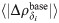
Phase-locking changes at WP1 are driven by local excitations of neural activity, differ between excited and baseline frequency bands, and are differentially related to structural and functional network properties.(A) Pairwise changes in the PLV inside the baseline band Δρbase when region i (Left) or region j ≠ i (Right) is perturbed. In this figure, regions i and j correspond to regions 4 (R–Medial Orbitofrontal) and 23 (R–Lateral Occipital), respectively. (B) Network-averaged absolute PLV changes in the baseline band 〈|Δρδibase|〉 caused by stimulation of different brain areas. (C) Pairwise changes in the PLV inside the excited band Δρexc when region i (Left) or region j ≠ i (Right) is perturbed. (D) Network-averaged absolute PLV changes in the excited band 〈|Δρδiexc|〉 induced by stimulation of different brain areas. (E) The quantity 〈|Δρδibase|〉
vs. structural node strength sistruc (Left), and the quantity 〈|Δρδiexc|〉
vs. structural node strength sistruc (Right). (F) The quantity 〈|Δρδibase|〉
vs. functional node strength sifunc (Left), and the quantity 〈|Δρδiexc|〉
vs. functional node strength sifunc (Right). In panels (E) and (F), insets indicate Spearman correlation coefficients between the plotted quantities and their associated p-values).